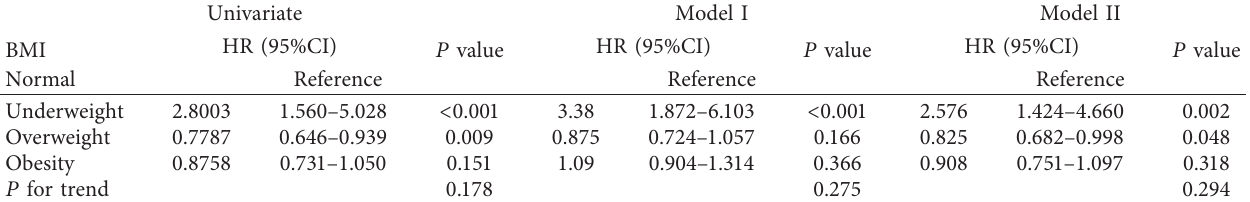
Table 2: Cox regression analyses of the relationship between BMI and all-cause mortality for patients after CABG.